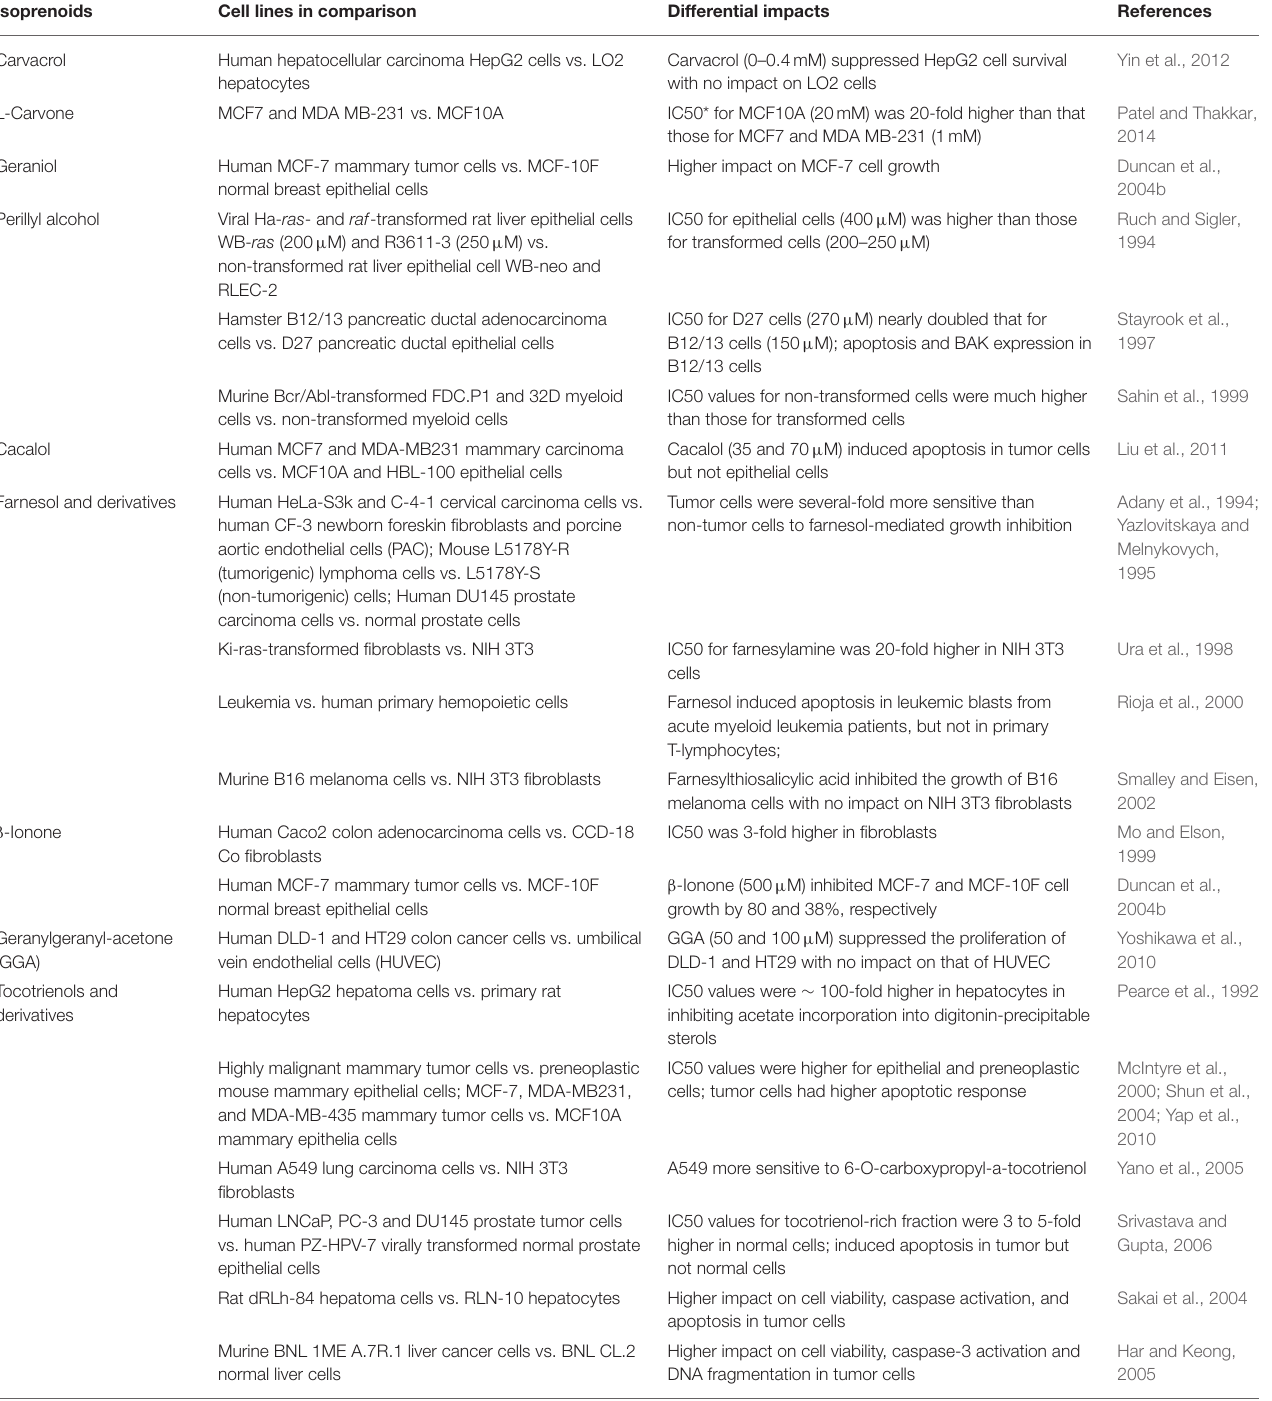
TABLE 2 | Differential sensitivities of tumor and non-tumor cells to isoprenoids-mediated HMGCR downregulation, growth suppression and apoptosis.